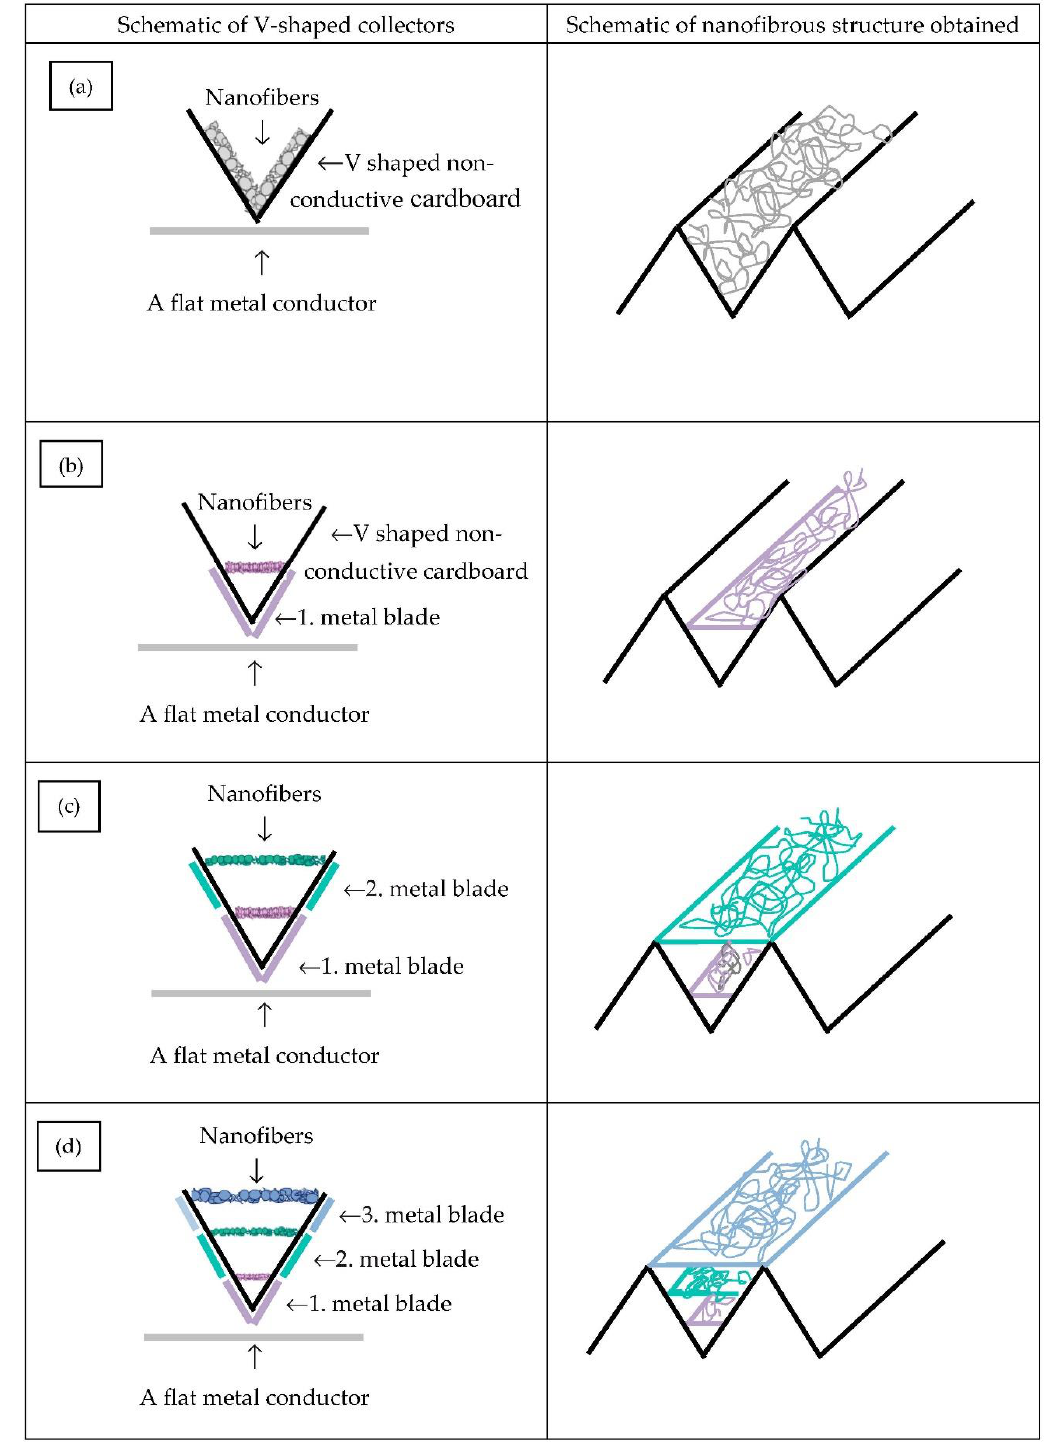
Figure 2. Schematic of 3-D nanofibrous layer producing setups for variations A–D ( a – d a; b; c; d; ).